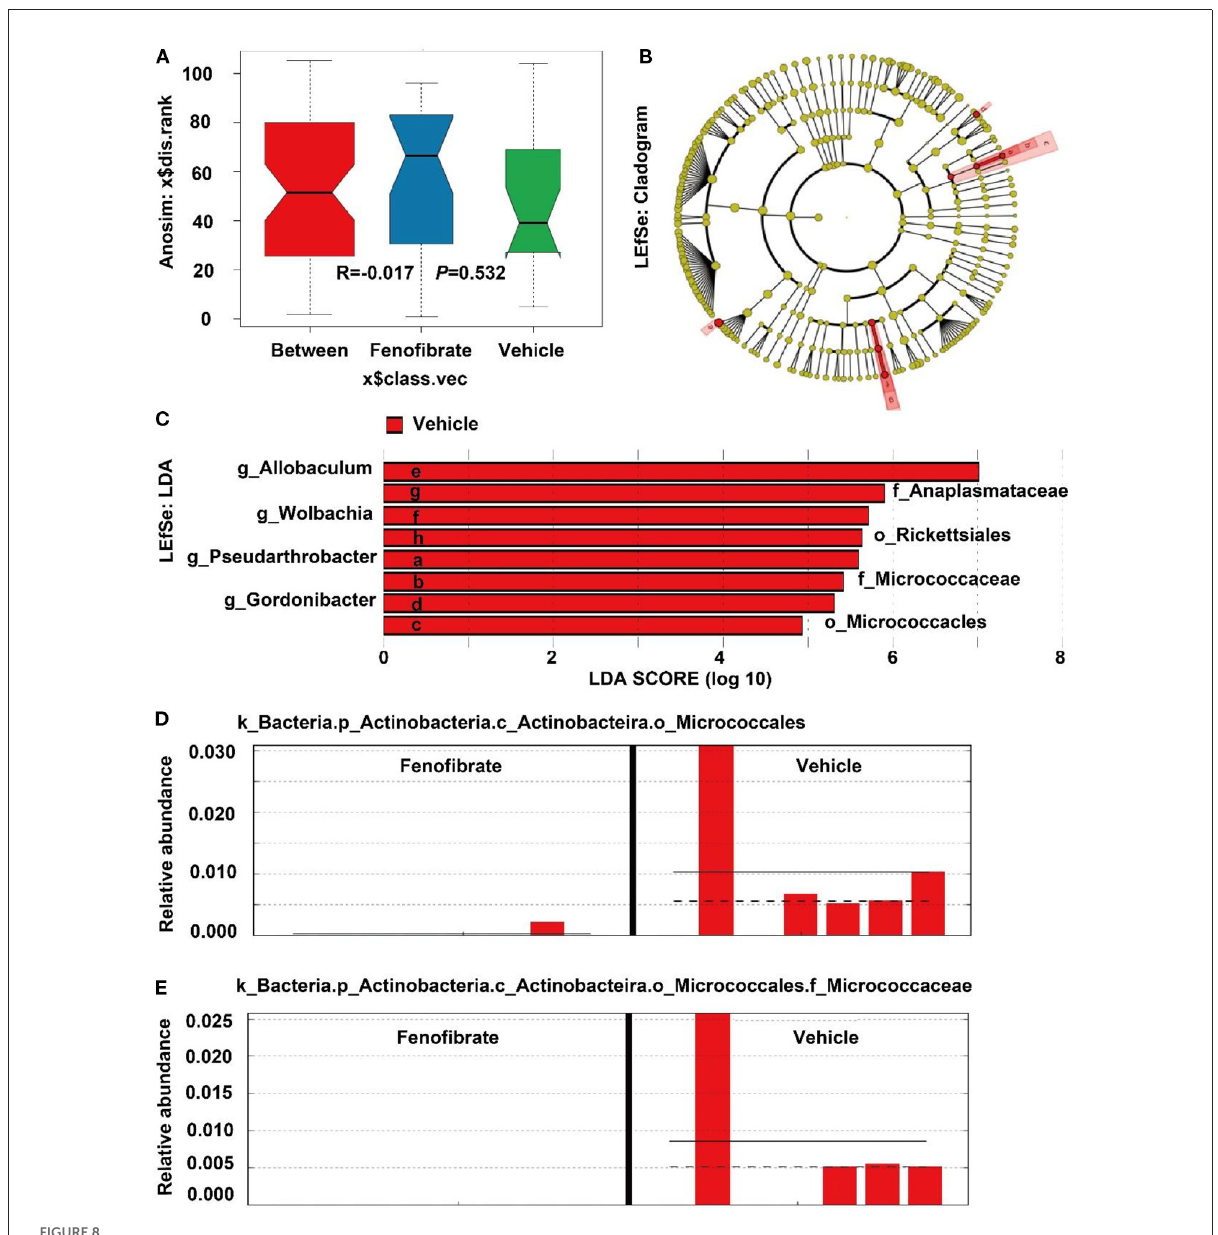
FIGURE8 Anosim and LDA Effect Size (LEfSe) analysis of the gut microbiota species. (A) Anosim analysis; (B) LEfSe analysis shown by cladogram; (C) LEfSe analysis shown by LDA score; (D,E) the relative abundance of some microbiota biomarkers in different samples. Vehicle: ob/ob mice were treated with 0.5mL of water by gavage for 13 weeks ( n = 7); Fenofibrate: ob/ob mice were treated with 0.5mL of fenofibrate suspension liquid at the dose of 20 mg/kg/d by gavage for 13 weeks ( n =